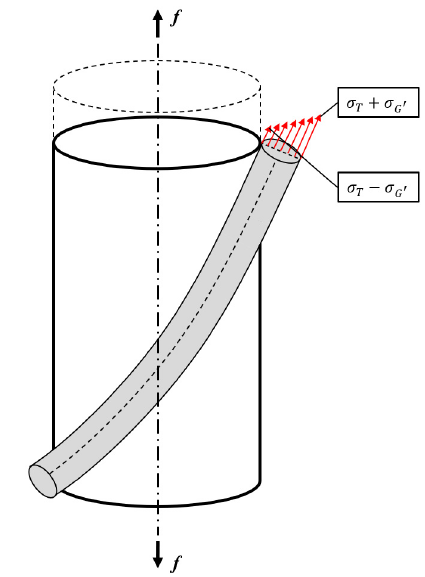
Figure 11. Stress diagram.